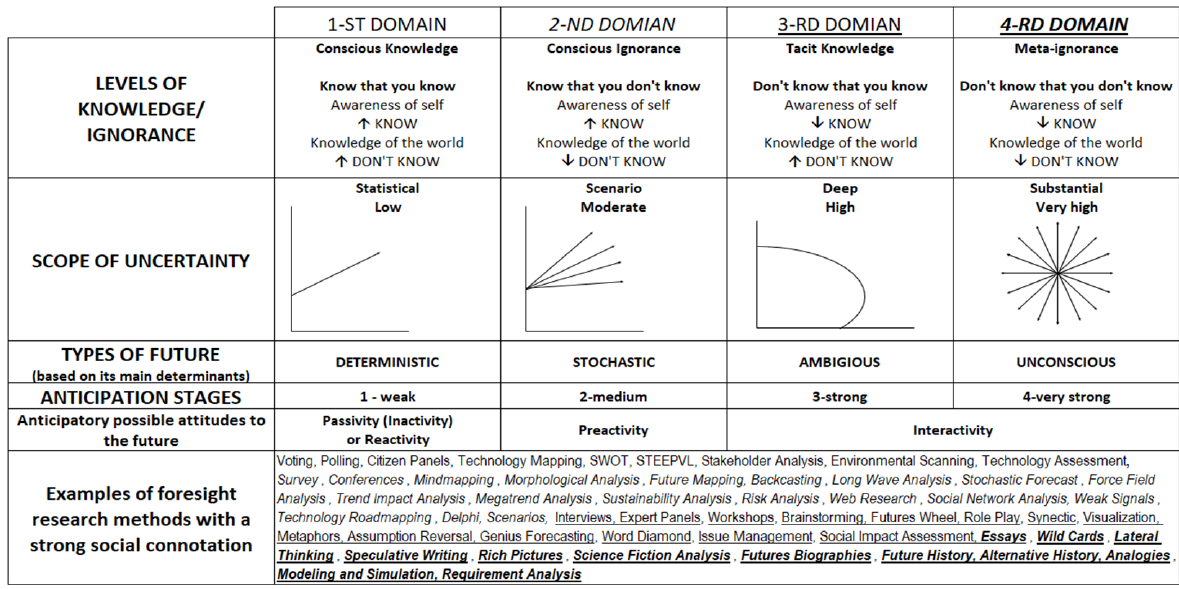
Figure 3. UKAF Matrix—effector system.